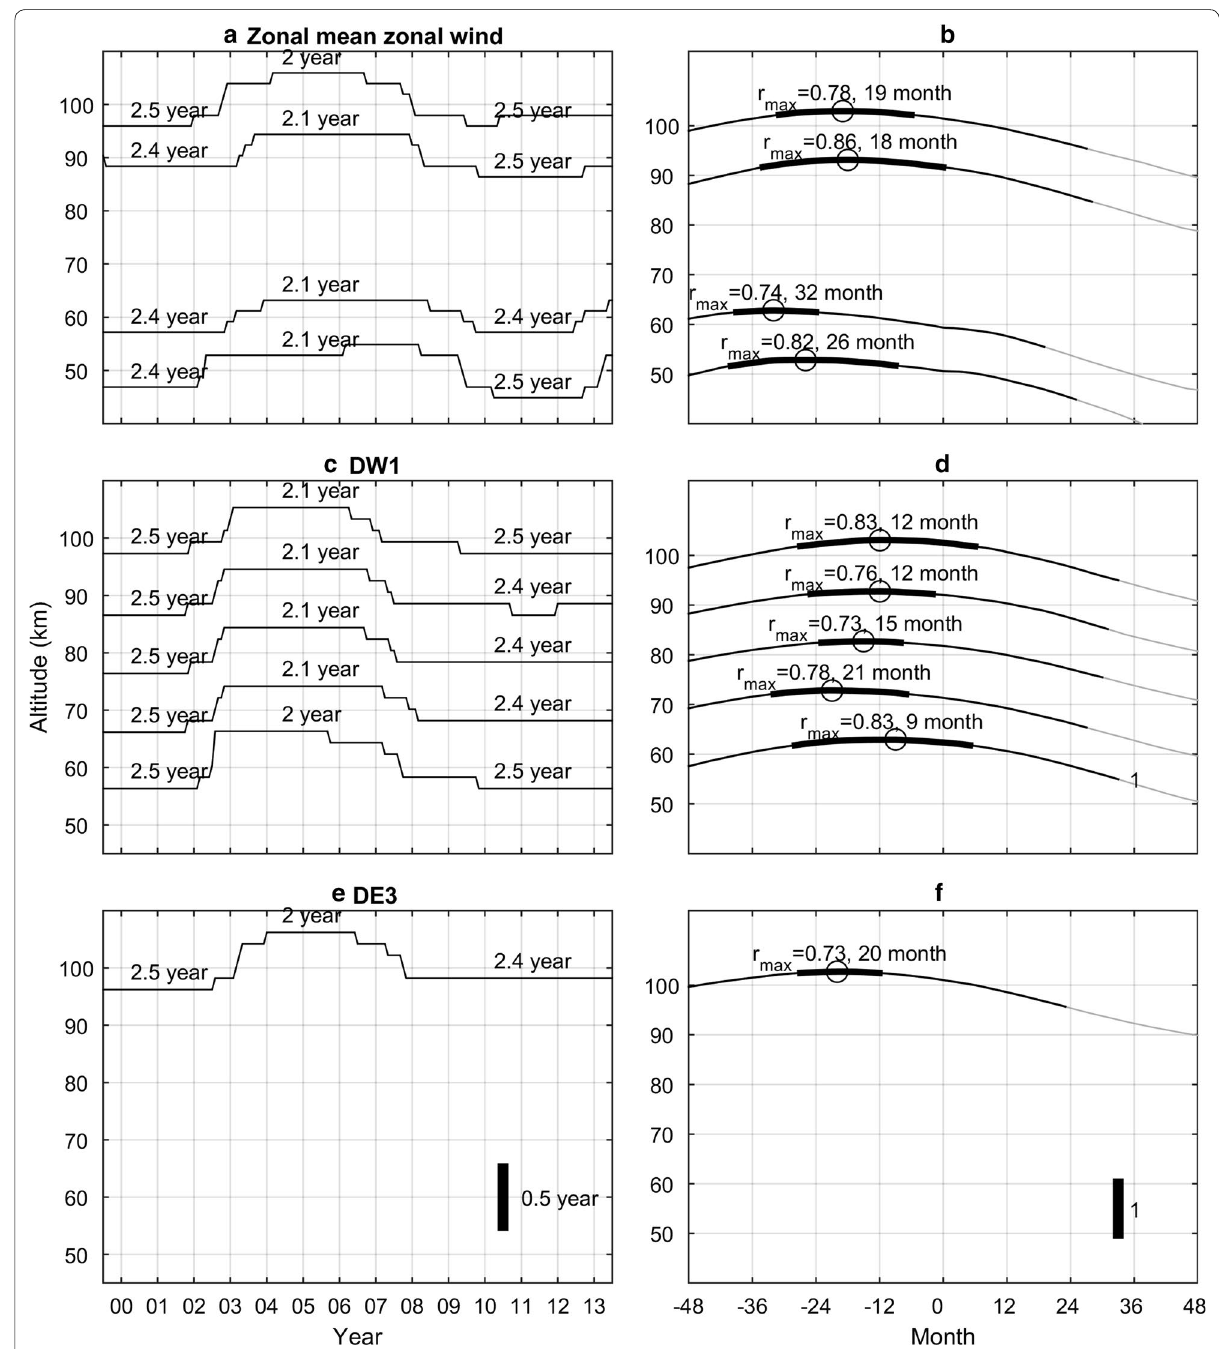
Fig. 5 (Left) Time series of the period of the QBOs in a the GAIA zonal mean zonal wind, c DW1, and e DE3 within the cone of influence zone (from July 1999 to June 2013). The periods are obtained from the wavelet spectra of the zonal wind and tidal amplitude (in the Additional file 1: Figs. S1–3). (Right) Correlation between the periods of the QBO‑scale component in ONI and the QBOs from GAIA b zonal mean zonal wind, d DW1, and f DE3 with 99% confidence